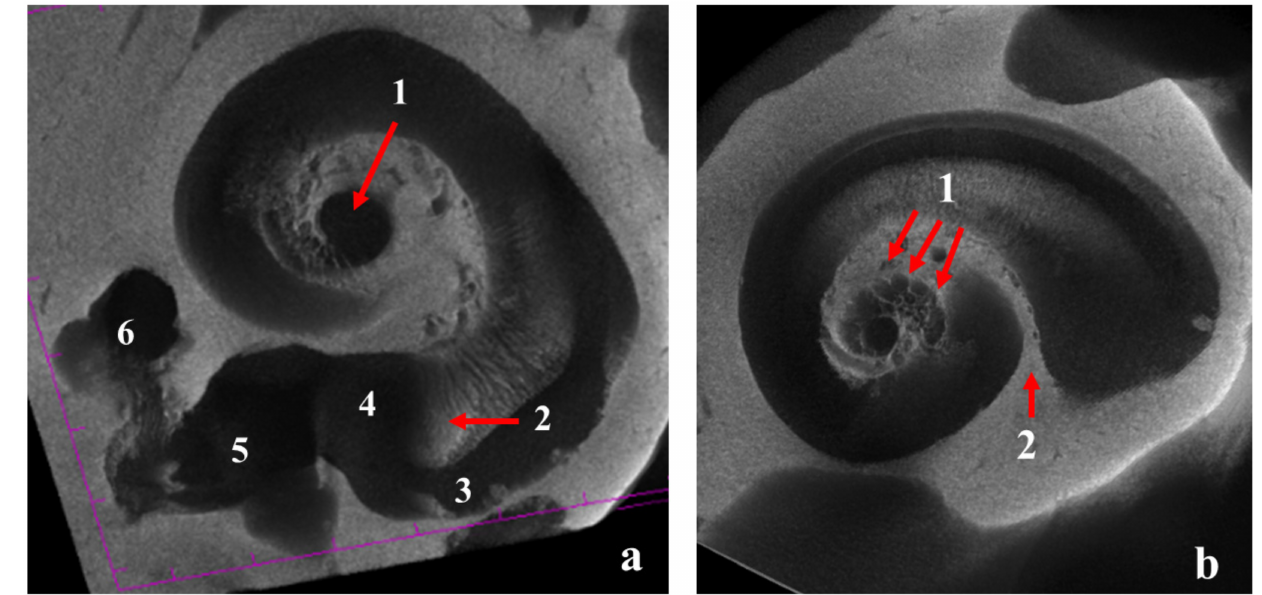
Figure 5. Horizontal cross sections of the cochlea at different levels of the spiral canal. ( a ) Basal turn: 1, modiolus with the bony cavity housing the cochlear nerve; 2, beginning of the osseous spiral lamina; 3, beginning of the scala tympani near the round window; 4, beginning of the scala vestibuli near the oval window; 5, vestibular cavity; 6, ampullar portion of semicircular canals. ( b ) Last turn: 1, cavities housing the spiral ganglion; 2, lamina of modiolus separating the first from the second turn of the cochlear